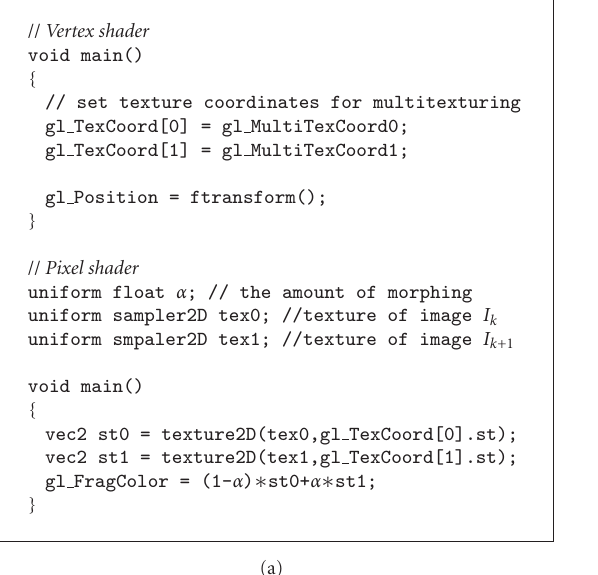
Figure 8: (a): Pixel shader code (and the associated vertex shader code), written in GLSL (OpenGL Shading Language), for implementing the photometric morphing. (b): Skeleton code in C for applying vertex blending in